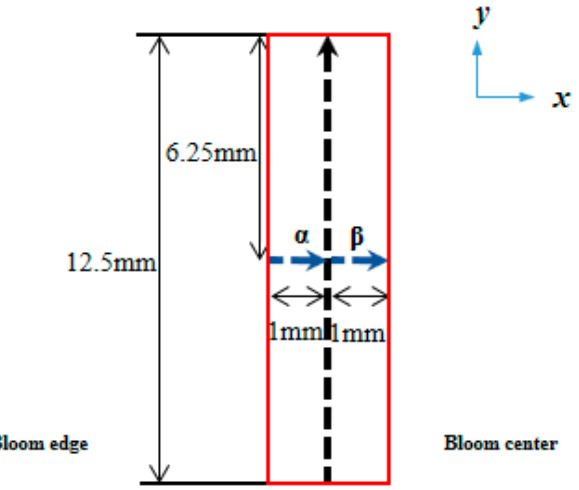
Figure 4. Schematic of measurement location of etched surface height at left side and right side of each position for velocity direction calculation. ( α and β are the horizontal measuring line of the left side and the right side at each position. From left to right, the measuring length is 1.0 mm at each side where 1001 measurement points are contained. The vertical dashed arrow corresponds to same arrow in Figure 3.)